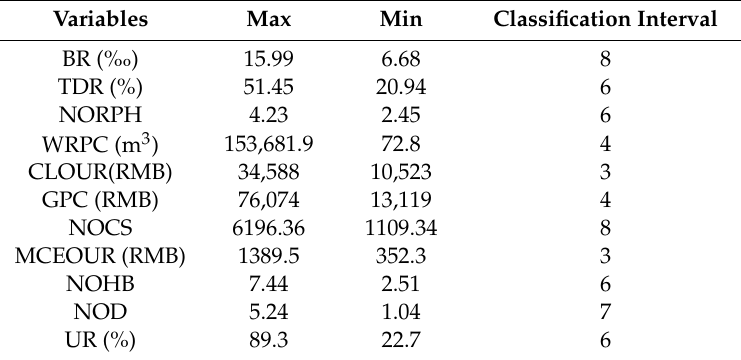
Table 3. Descriptive analysis and discretization results of social and environmental factors.